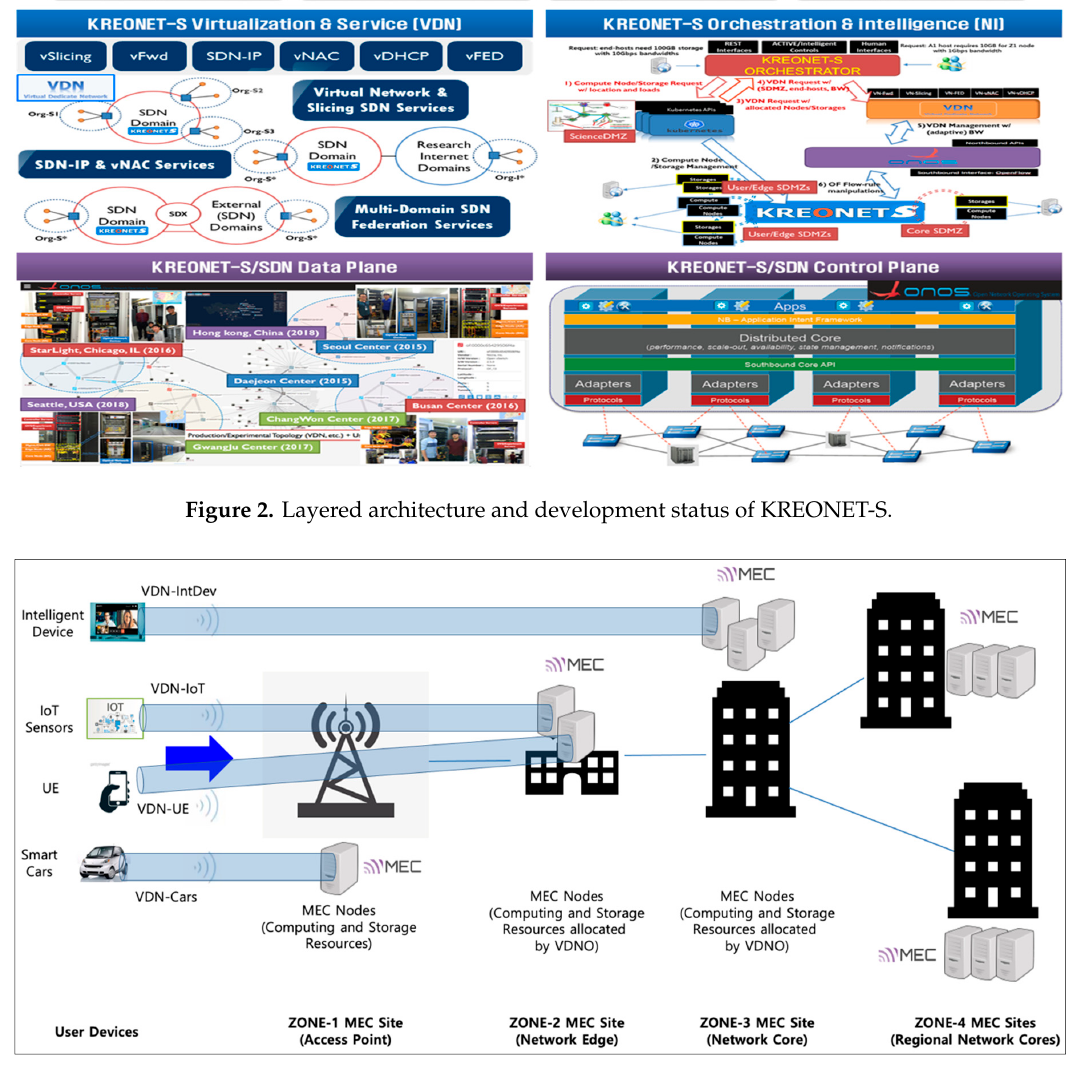
Figure 3. The hierarchical multi-access edge computing (MEC) service model based on virtual dedicated network (VDN) and VDN orchestrator (VDNO).